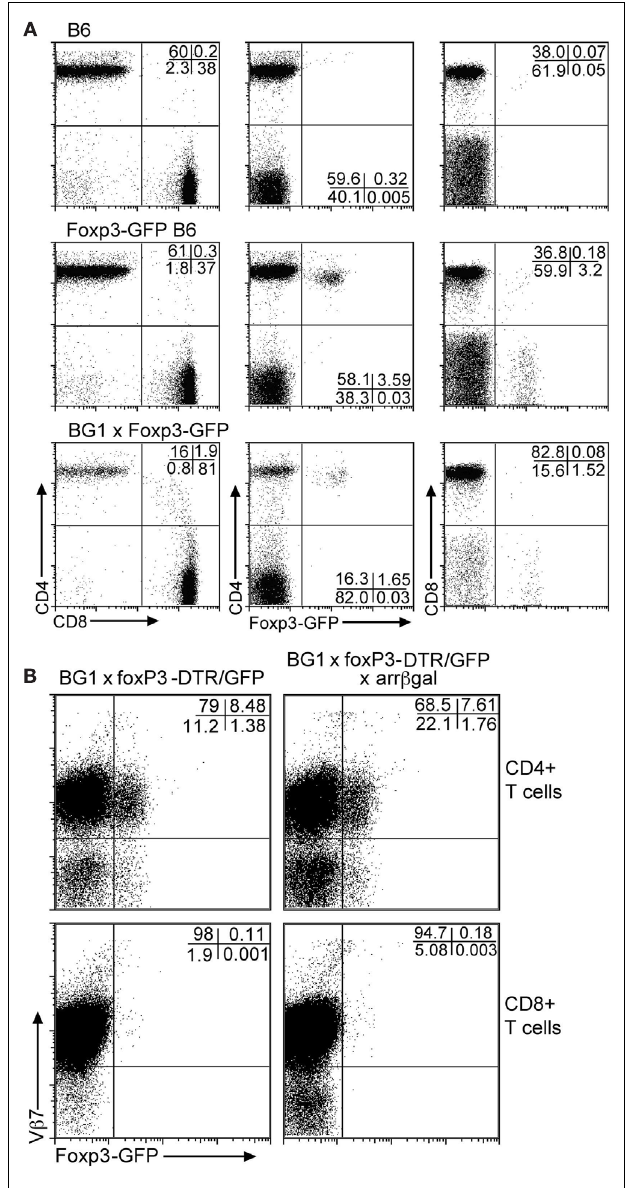
FIGURE 2 |Although the BG1 mice have a reduced population of CD4T cells, the FoxP3-GFP + cells in BG1x Foxp3-DTR/GFP mice are concentrated in the CD4 population. (A) Comparison of Foxp3-GFP + T cells in PBL from mice with and without theTCR transgenes. (B) Association of the Foxp3-GFP + Tregs with theV β 7 + CD4 and CD8T cells. The distribution ofTregs in theV β 7 + populations ofT cells from peripheral blood was unaffected by retinal β gal expression. Analyses were gated on CD3 + T cells. Representative plots are shown.